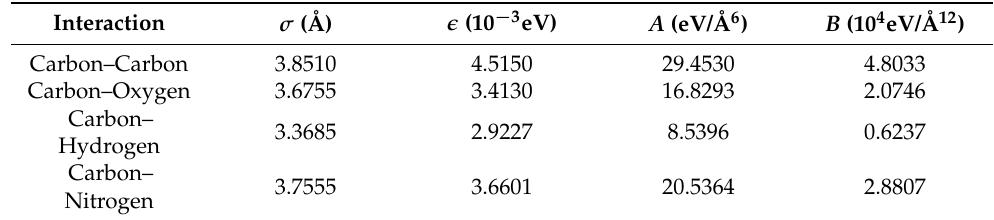
Table 1. Lennard-Jones parameters and constants obtained by the mixing rule used in this model.